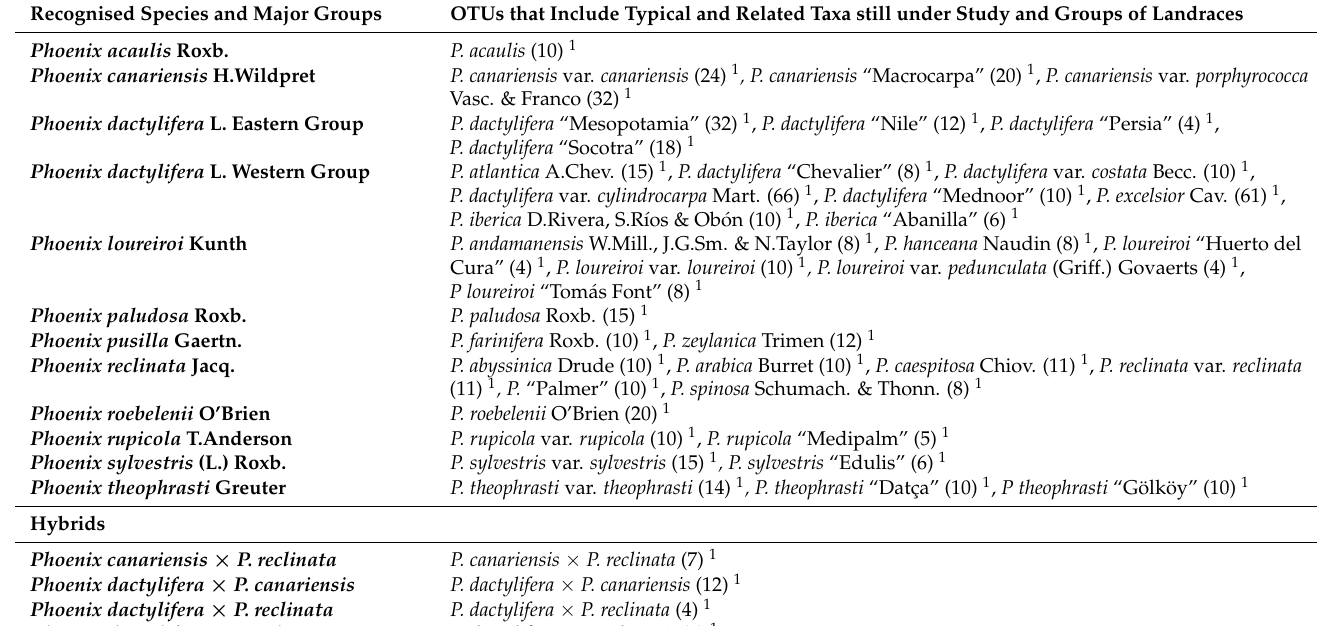
Table 1. Accepted taxa and their operative taxonomic units